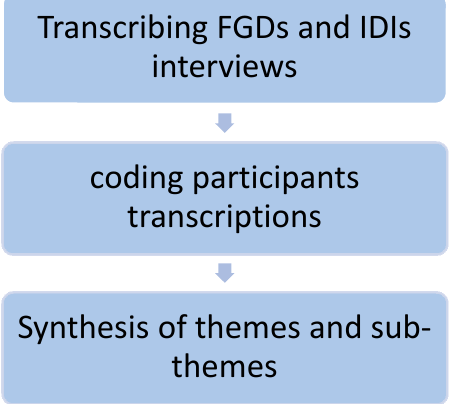
Figure 1. Qualitative data analysis sequence.